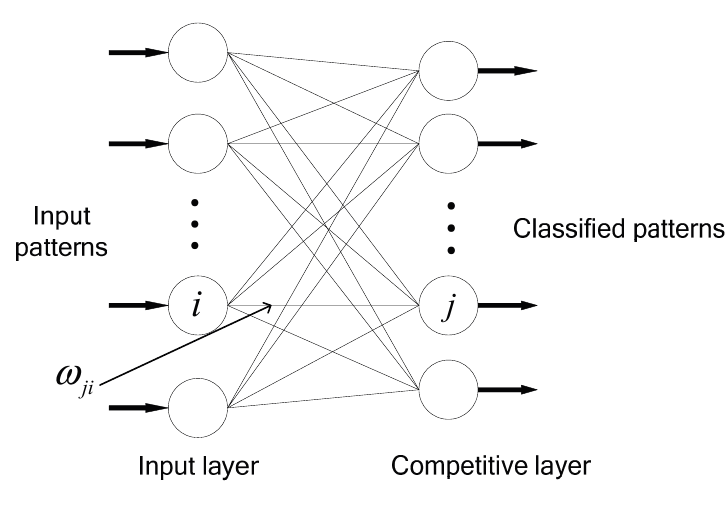
Figure 2. Structure of the Kohonen